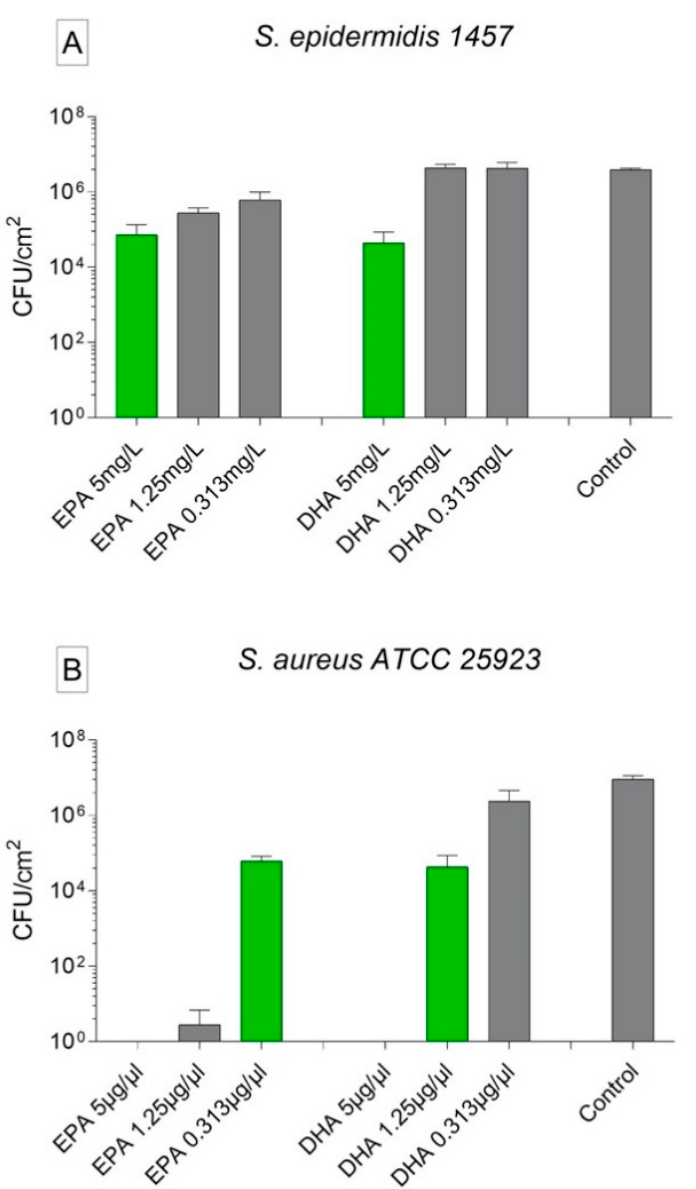
Figure 4. Activity of ω -3 PUFAs on biofilm killing-treatment of biofilms with EPA and DHA, and only with nutrient medium as control. The data are stated as mean ± SEM. ( A ) S. epidermidis 1457; ( B ) S. aureus ATCC 25923. In green, values significantly different from control group ( p < 0.0001). Statistically analyzed with two-way ANOVA and Turkey’s multiple comparison tests. All the tests were repeated twice and carried out in triplicates.